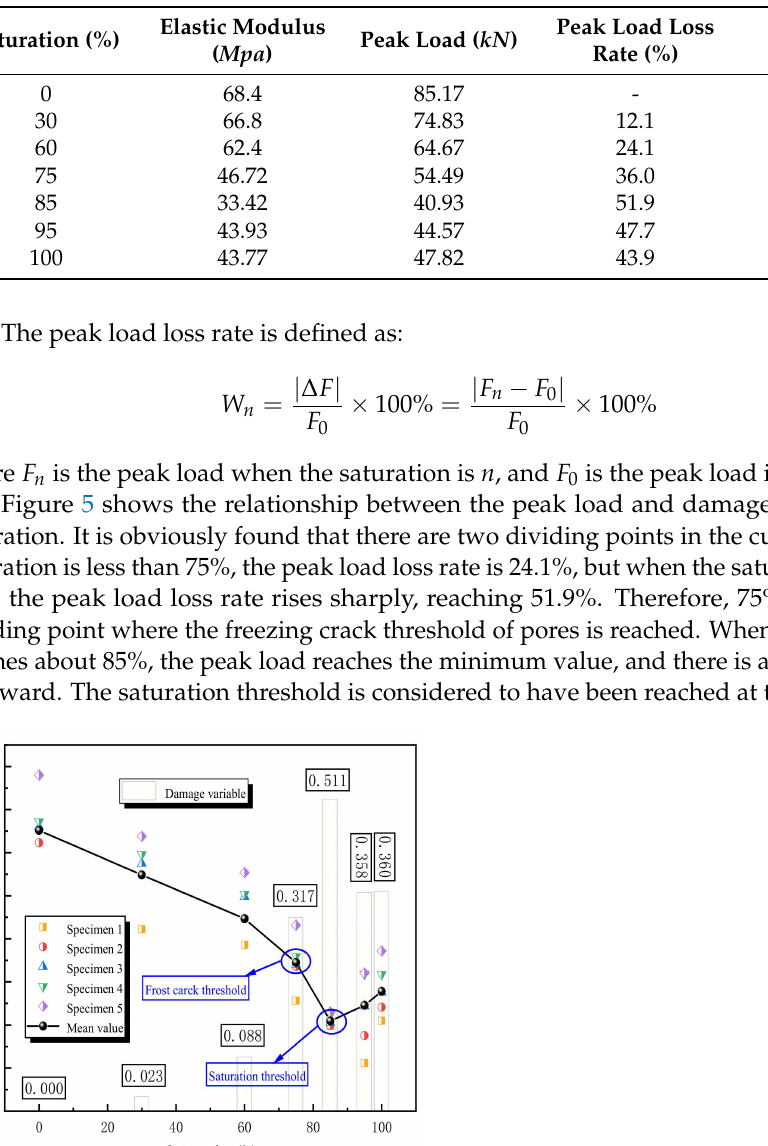
Table 2. Uniaxial compression test results.